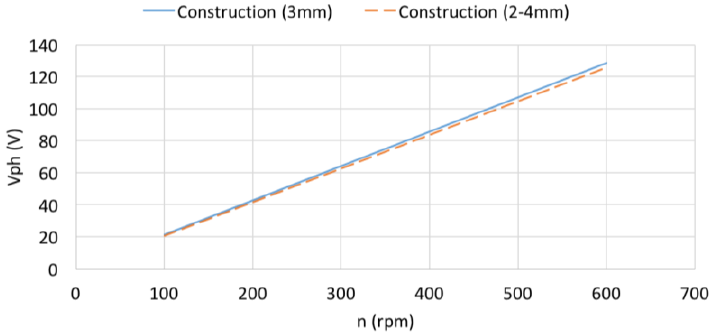
Figure 19. Plot versus the speed of the output phase current in constructed model with 3 mm air gaps compared to that of the constructed model with 2–4 mm air gaps.